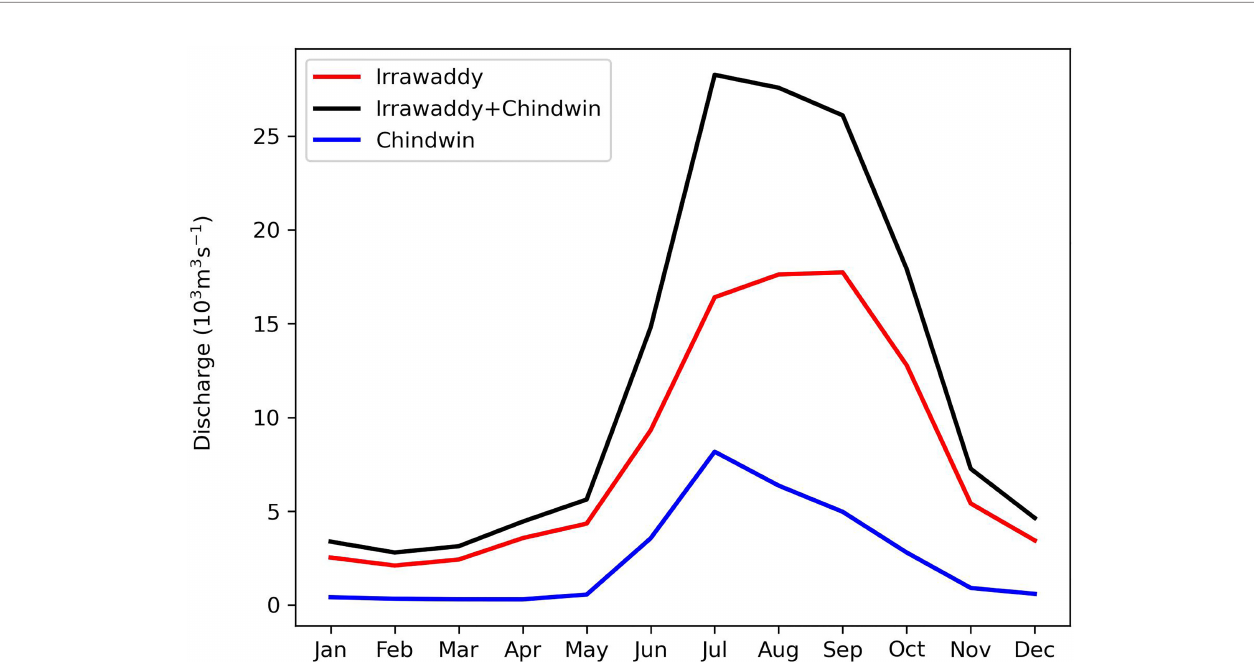
FIGURE 1 | Seasonal cycle of freshwater discharge from Irrawaddy and Chindwin rivers in 10 3 m 3 s -1 . Data for the discharge for these rivers is obtained from Dai and Trenberth Global River Flow and Continental Discharge Dataset (Dai and Trenberth, 2002; Dai et al.,